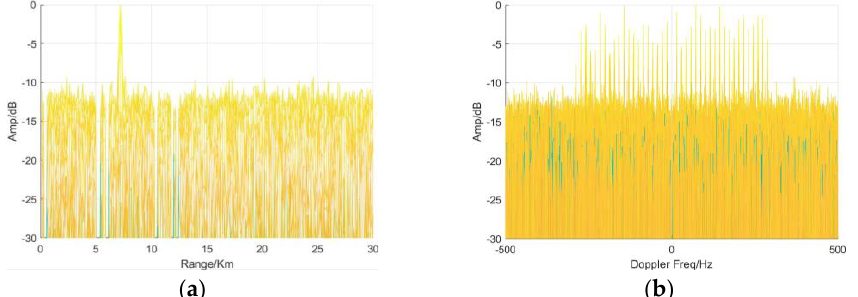
Figure 9. The CI after iteration elimination: ( a ) the range – amplitude plane; ( b ) the Doppler frequency – amplitude plane.